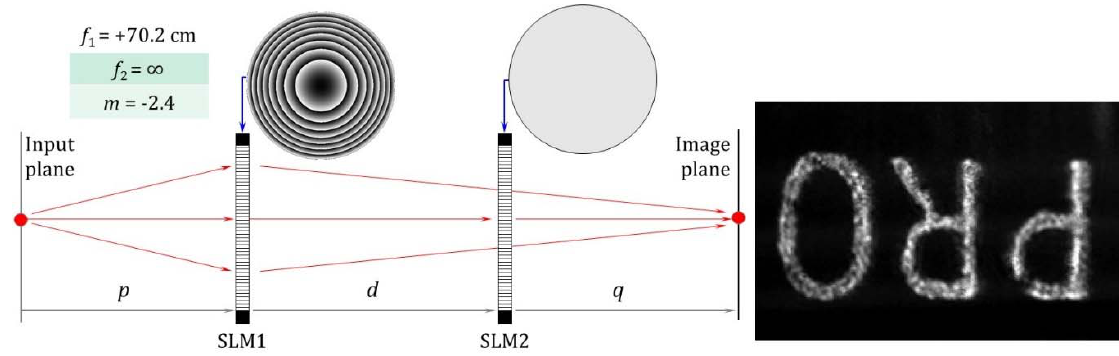
Figure 4. Zoom system configuration with f 1 = 70.2 cm and f 2 = ∞ and experimental image with magnification of m = − 2.4.